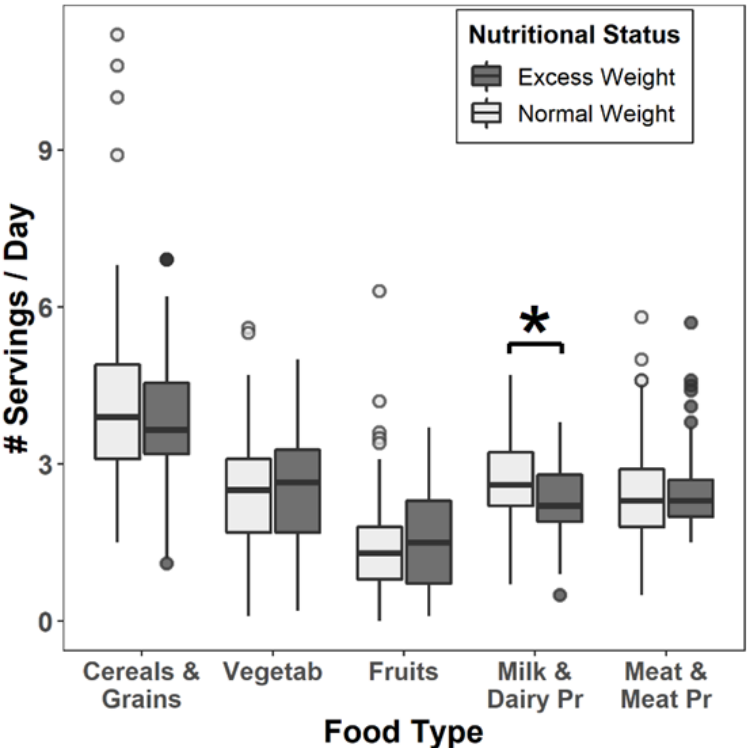
Figure 1. Amount of servings/day for the different food groups according to the schoolchildren’s nutritional status. (* p = 0.039 Difference between the number of milk and dairy products servings/day according to nutritional status. Data adjusted by age and sex). Table 3. Physical activity and sleep length of the schoolchildren in accordance with nutritional